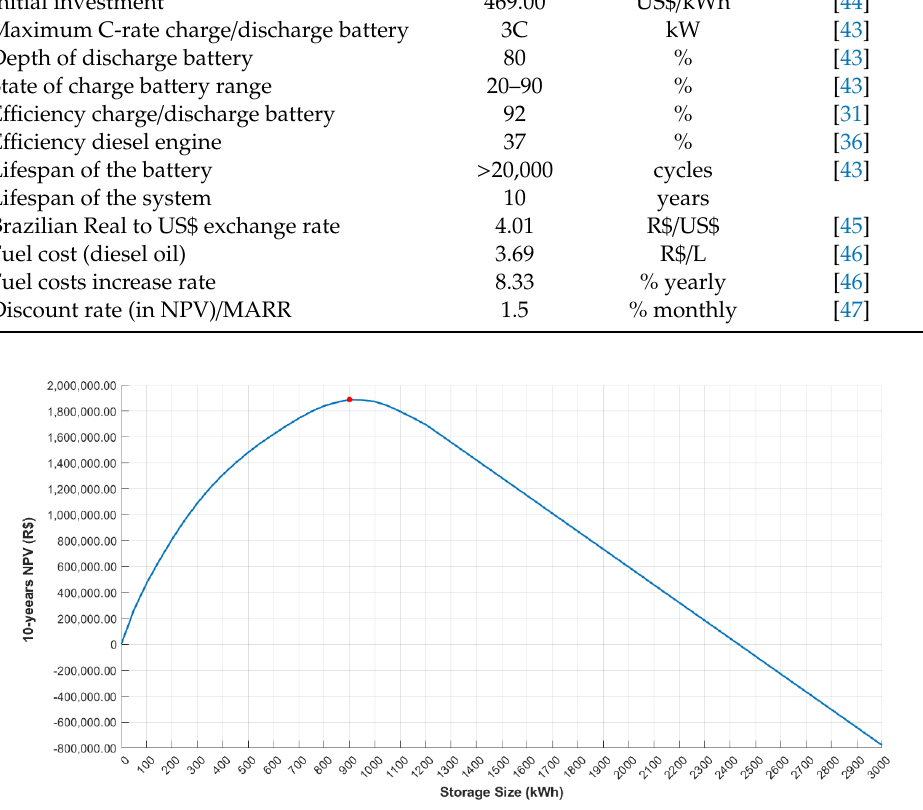
Figure 8. Storage system optimal sizing.